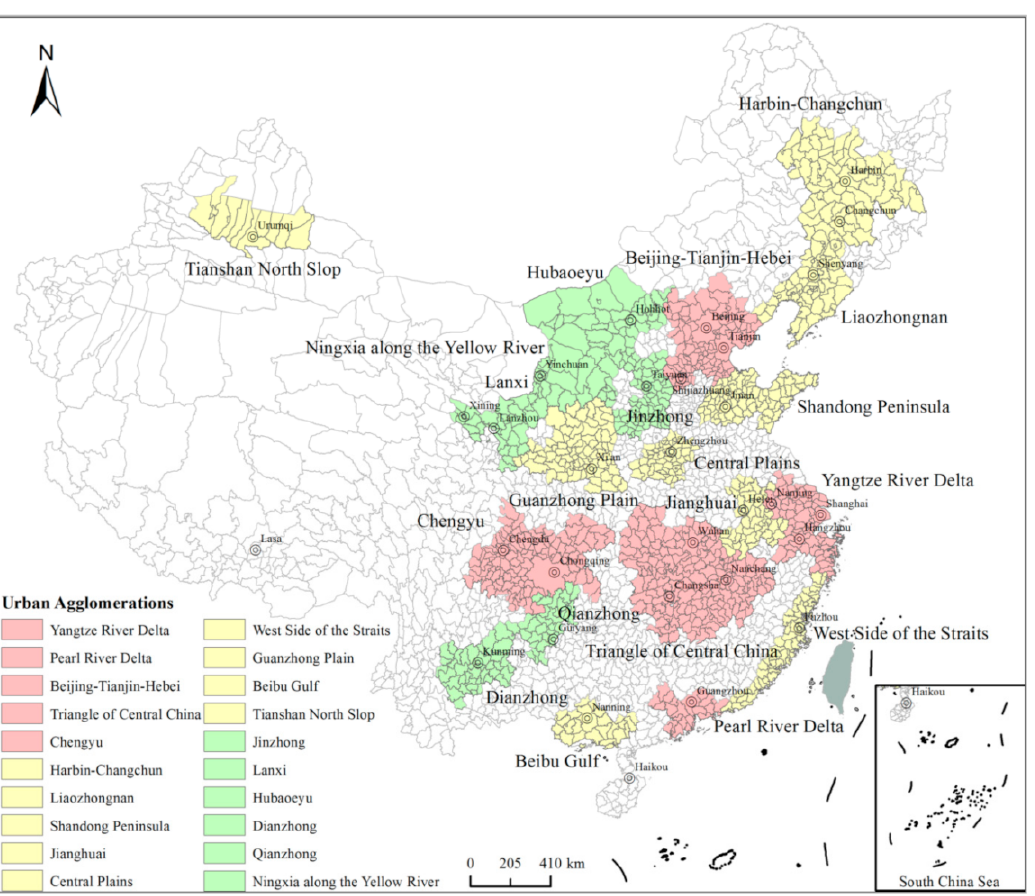
Figure 8. Distribution structure of urban agglomeration following the “5 + 9 + 6” plan in